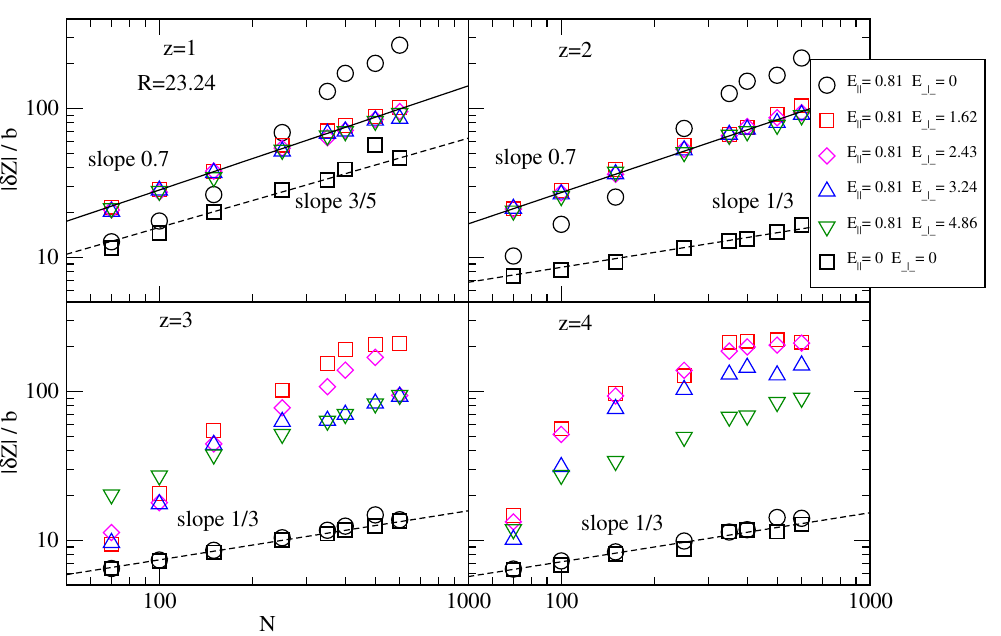
Figure 7. Graph similar to Figure 6 of axial extension normalized by the bond length, | δZ | /b , as a function of chain length N , for the largest cylinder of radius R = 23 . 24